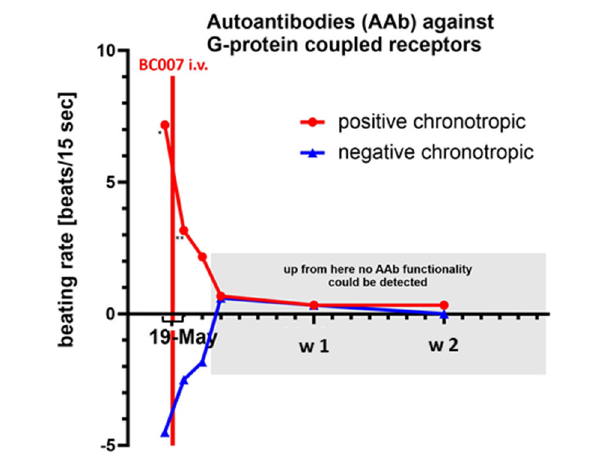
FIGURE 3 | Autoantibodies (AAbs) against G-protein coupled receptors (ß2-AAb, AT-1-AAb, α 1-AAb, MAS-AAb, and M2-AAb) before (at the day of infusion, before the treatment, single star) and after treatment with BC 007 [after 2h (double star), 1 day, 2 days, and 1–4 weeks]: functional activity of the positive and negative chronotrope effect of the different AAbs were reduced even after 2h and functionally inactive at least over the observation period of 4 weeks (cut-off 1.8 beats/15s); w-week.